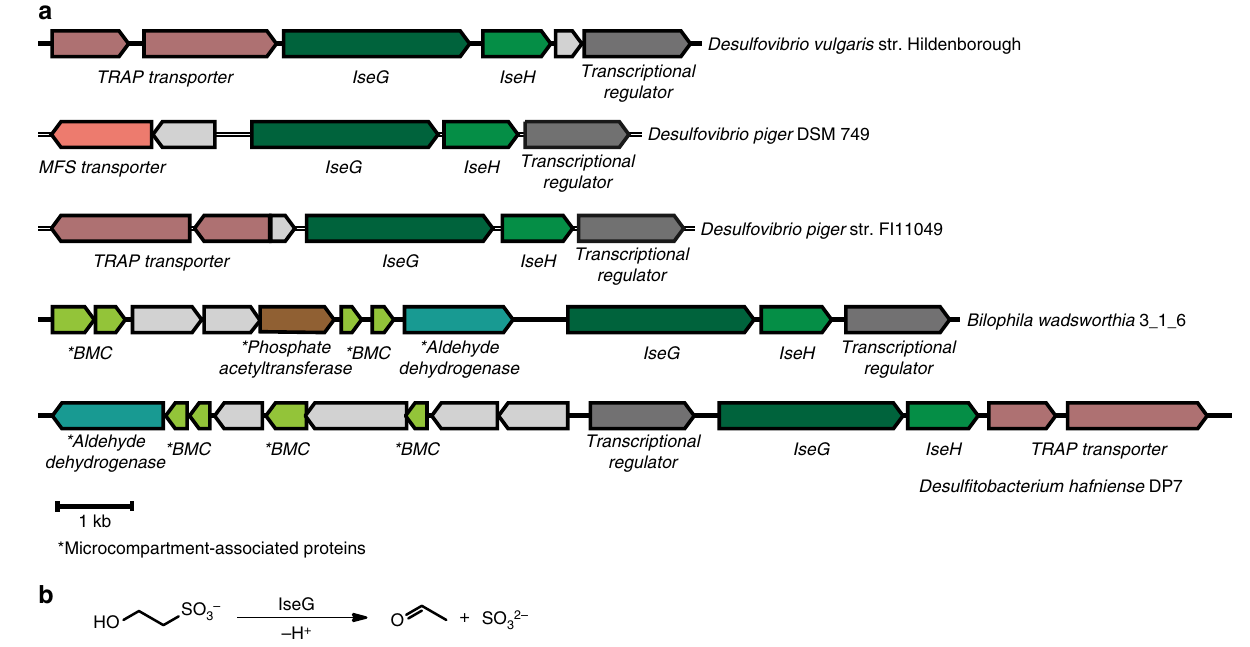
Fig. 1 Genome neighborhood and proposed reaction. a The IseG genome neighborhoods in sulfate-reducing bacteria Desulfovibrio vulgaris str. Hildenborough, Desulfovibrio piger DSM749, Desulfovibrio piger str. F111049 (a gram-negative sulfate-reducing bacterium), Desul fi tobacterium hafniense DP7 (a gram-positive sul fi te-reducing bacterium) and sul fi te-reducing bacterium Bilophila wadsworthia 3_1_6 (a gram-negative sul fi te-reducing bacterium) are shown. In many cases, IseG is associated with a TRAP transporter and microcompartment proteins. b Proposed IseG-catalyzed